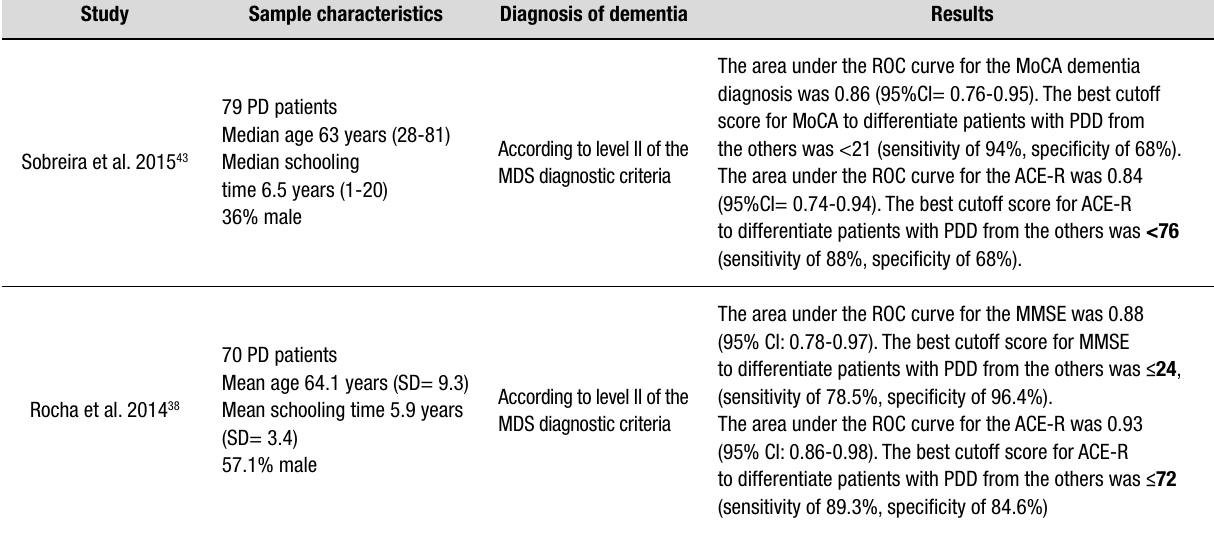
Table 4. Clinical Brazilian research studies with brief global cognitive instruments in Parkinson’s disease dementia.